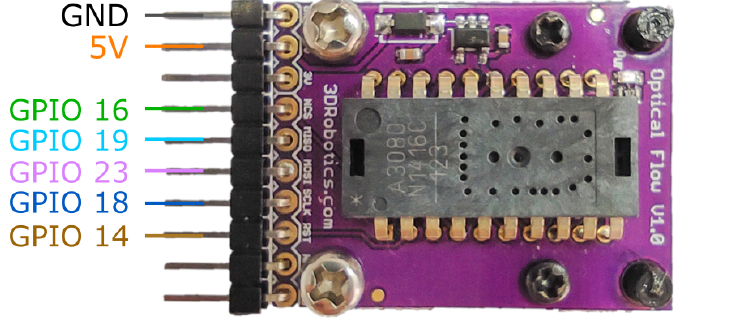
Figure 7. Velocity sensor ADNS3080 wiring